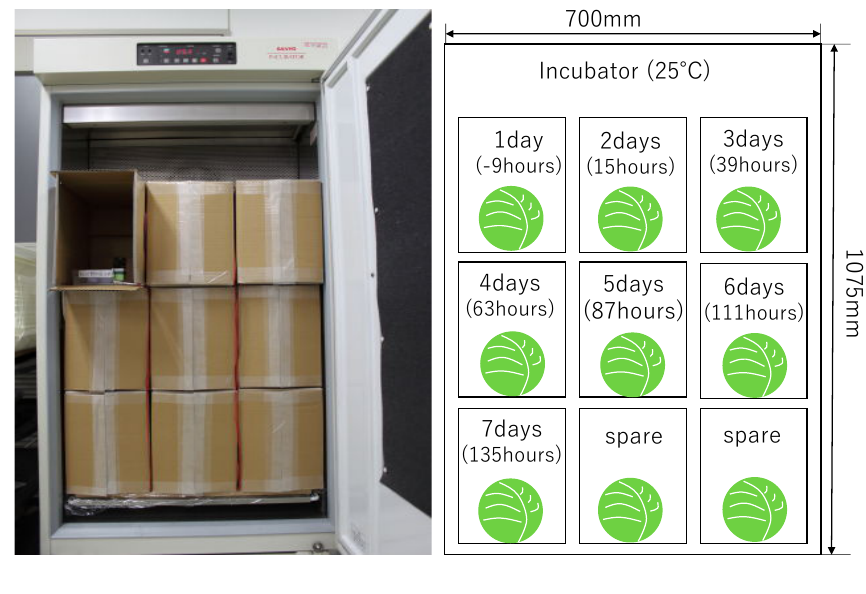
FFiigg.. 33 TThhee ccaarrddbbooaarrdd bbooxx iinnssttaalllleedd iinn tthhee iinnccuubbaattoorr ffoorr ddeemmoolliittiioonn eexxppeerriimmeenntt.. 672 Fig. 3: The cardboard box installed in the incubator for demolition experiment.